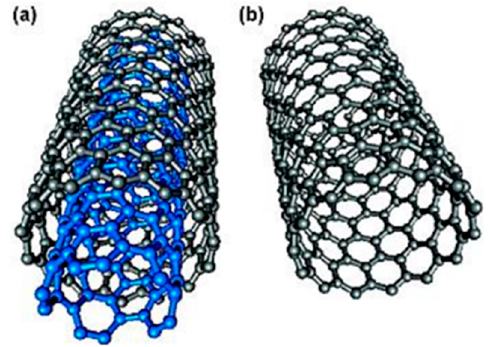
Figure 4. The structures of ( a ) MWCNTs and ( b ) SWCNTs. Reprinted with permission from Ref. [80]. Copyright 2009, the American Chemical Society.